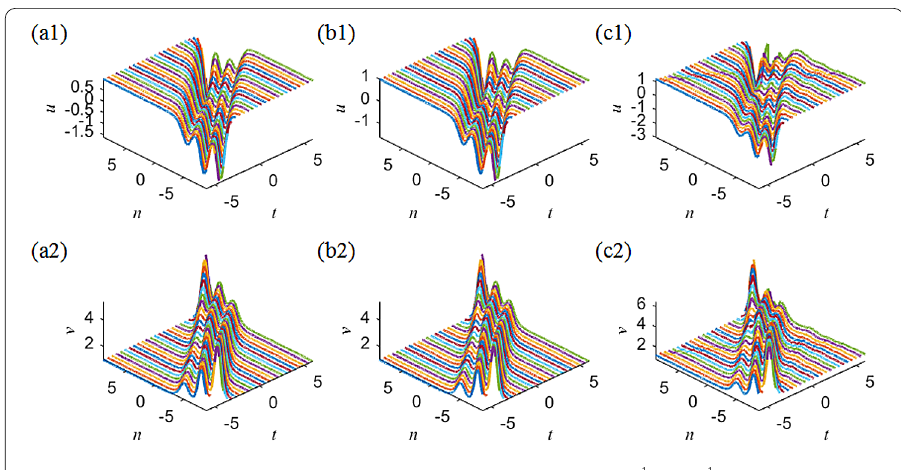
Figure 15 Three-soliton solution (52) with the parameters r 1 = 1, r 2 = –1, r 3 = 1 λ